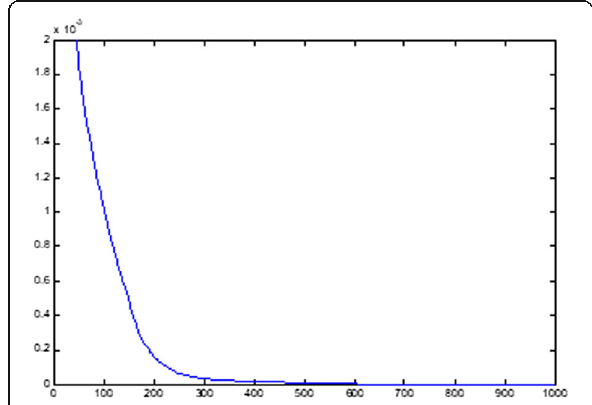
Fig. 3 Matrix eigenvalues of principal component analysis